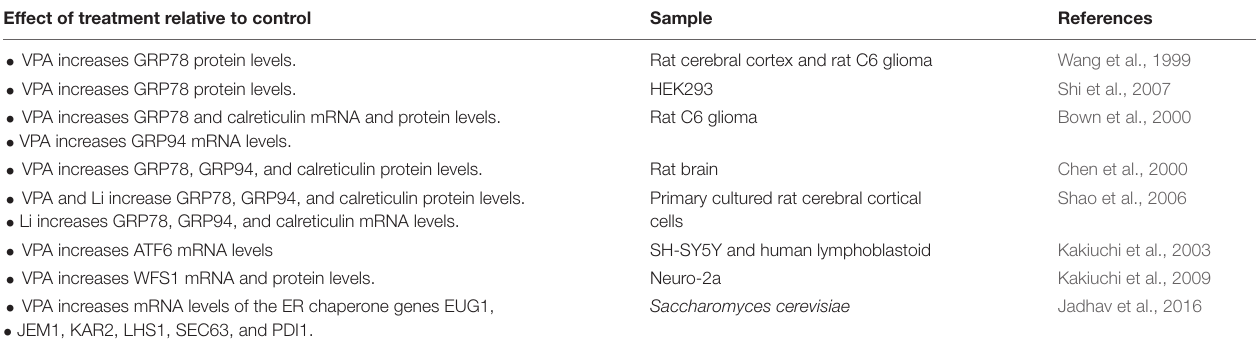
TABLE 2 | Mood stabilizers alter the expression of UPR target